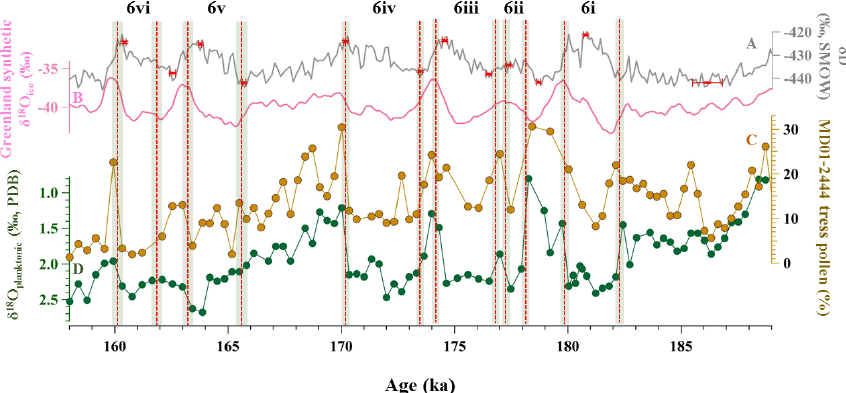
Figure 3. The durations of the six NA stadials during MIS 6: (a) δ D of the EDC ice core (Jouzel et al., 2007), (b) synthetic Greenland δ 18 O ice record (Barker et al., 2011), (c) tree pollen percentage in the MD01-2444 core (Margari et al., 2010) and (d) δ 18 O of planktonic foraminifera in the MD01-2444 core (Margari et al., 2010). Proxy data shown here are given on the AICC2012 age scale. Red lines indicate the midpoints of the stadial transition of both δ 18 O of planktonic foraminifera and tree pollen in MD01-2444. Light green bars indicate the uncertainty of the duration of each stadial transition, estimated as half the temporal difference between maxima and minima of δ 18 O of planktonic foraminifera before and after the transition. Red dots indicate minima and maxima of δ D in the EDC ice core as selected in this study. The event numbers are indicated at the